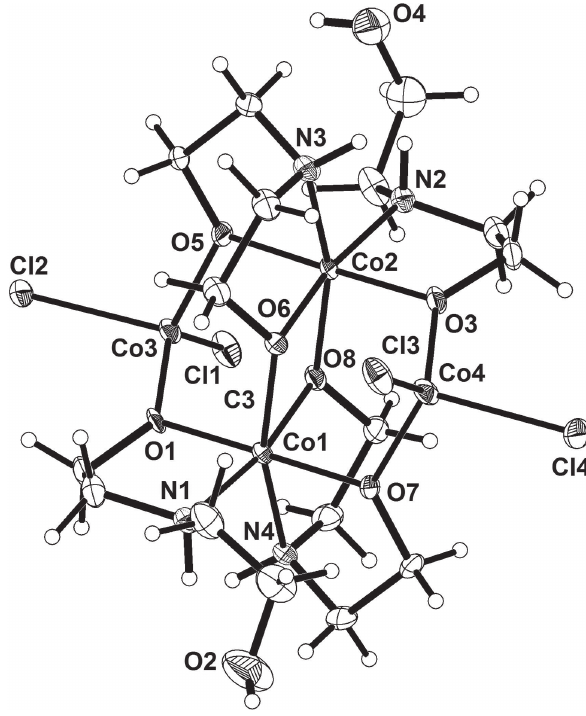
Table 1: Data collection and